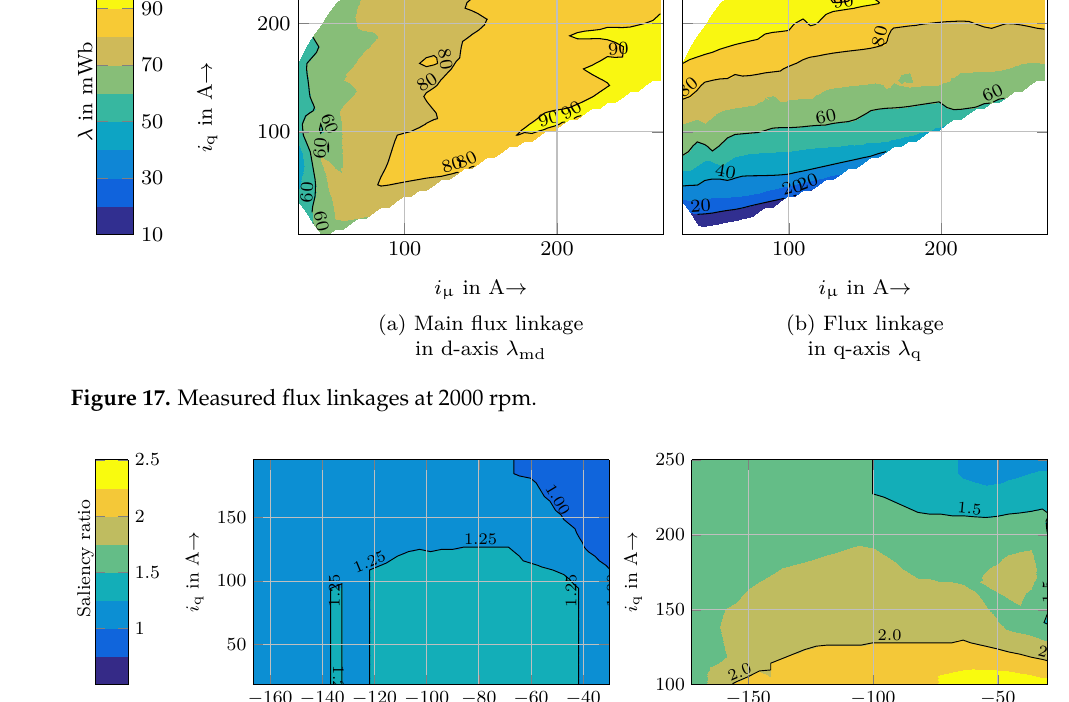
exemplary for two constant excitation currents, ( c , d ) absolute d,abs